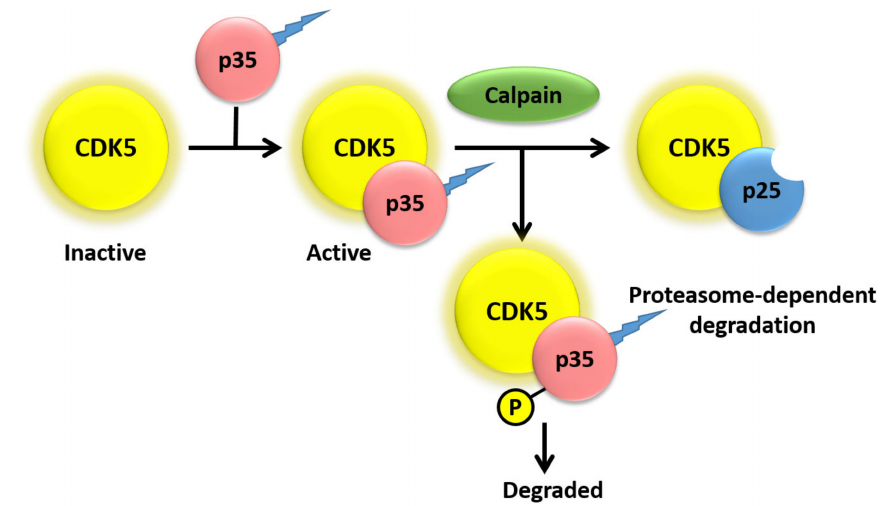
Figure 2. CDK5 activation is initiated by binding to the myristoylated regulatory